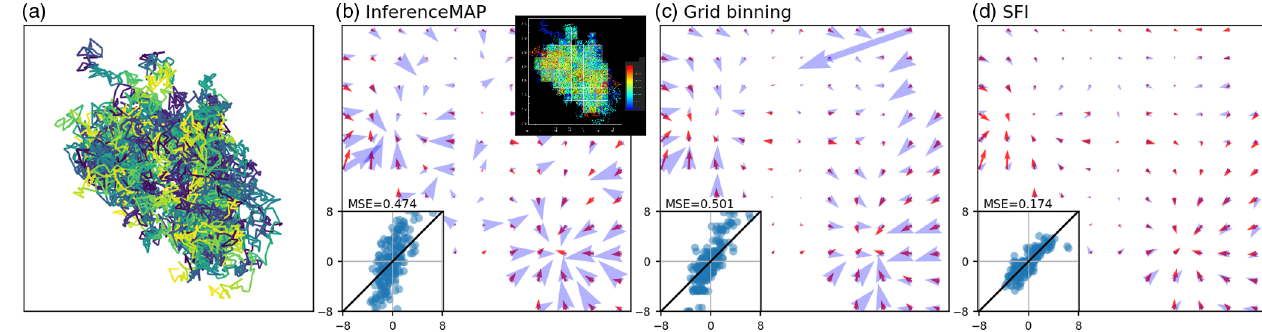
FIG. 10. Comparison of the performance of the three methods on a set of N ¼ 128 noisy trajectories. (a) The trajectories in the raw dataset exploited by each method. (b) – (d) The inferred drift field (thick light blue arrows) and the exact one used to generate the data (thin red arrows). The lower left insets show scatter plots of the inferred versus exact drift components, with an indication of the normalized mean-squared error (MSE). Top right inset of (b): Screen capture of the I NFERENCE MAP software used for this drift field. While methods (b) and (c) capture the qualitative shape of the drift field, they appear biased, and consistently overestimate the drift for noisy data. In contrast, our method shows quantitative agreement with the exact drift